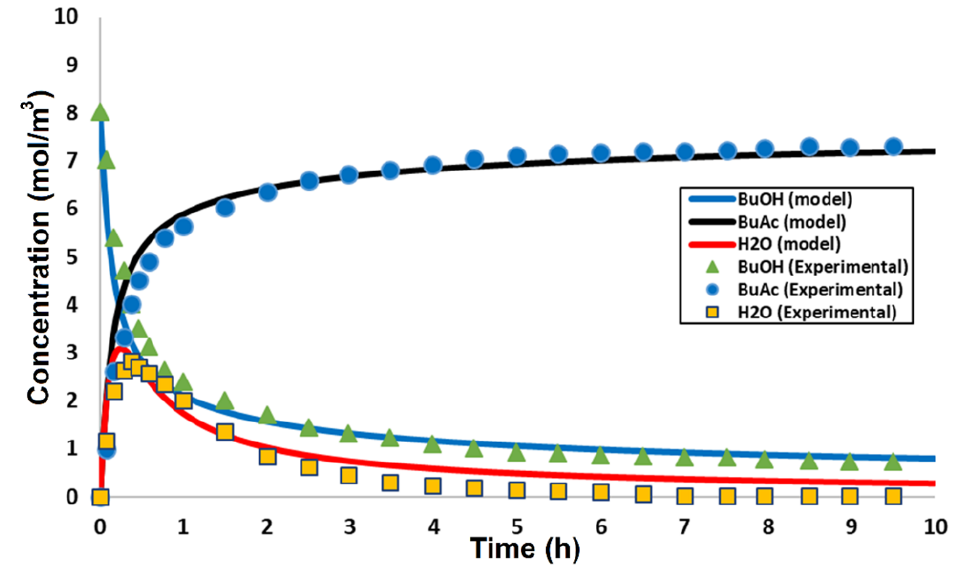
Figure 3. Components concentration as a function of the residence time of the membrane reactor.